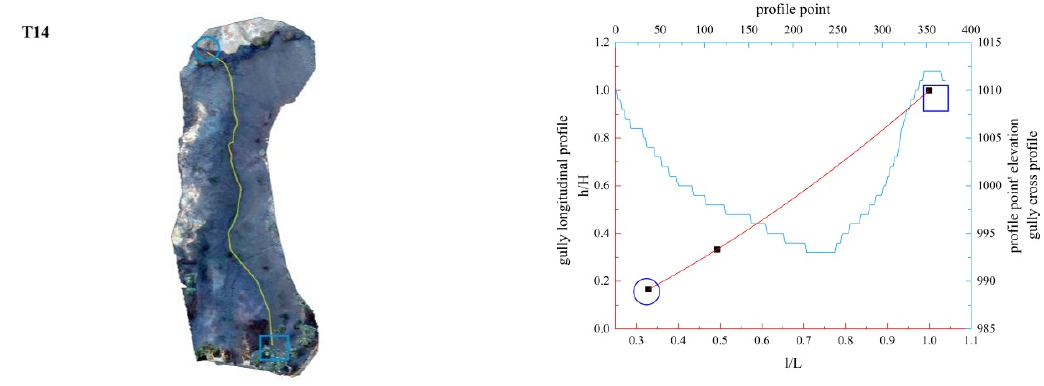
Figure 12. Gully shape and profile fitting diagram of T13.